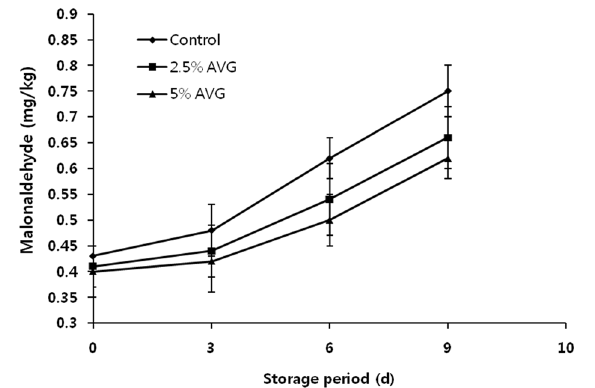
Figure 1. Lipid oxidation of goat meat nuggets containing different concentrations of Aloe vera gel (AVG) during refrigerated